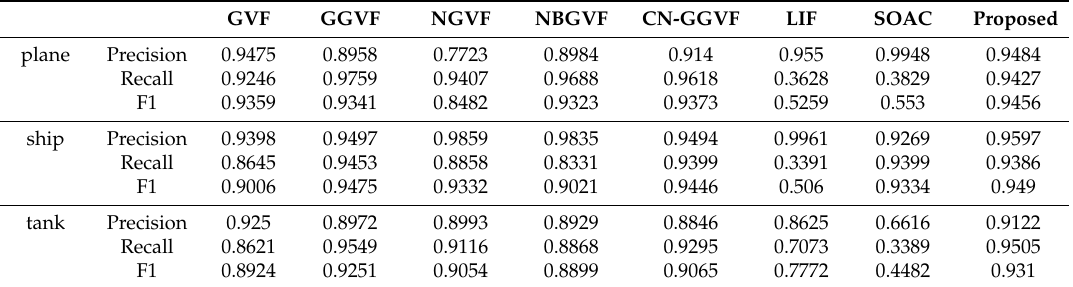
Table 1. Quantitative analysis results of usual infrared images after segmentation.